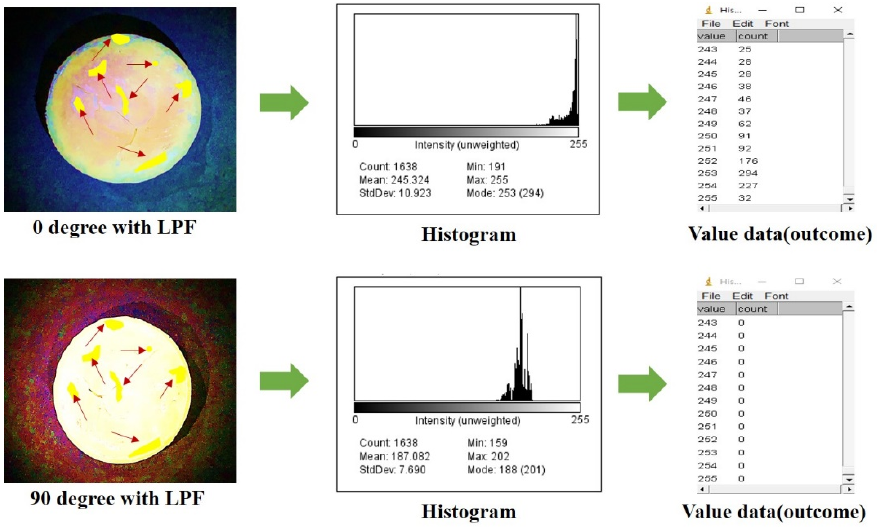
20 of 25 ( c ) Figure 18. Laser applications ( a ) test configuration ( b ) without LPF ( c ) with LPF. In Figure 19, the captured images were simulated using the region of interest (ROI) program. In the simulation results, when the rotation angle θ of the filter is 0°, the specular reflection occurrence position is indicated by a yellow point.